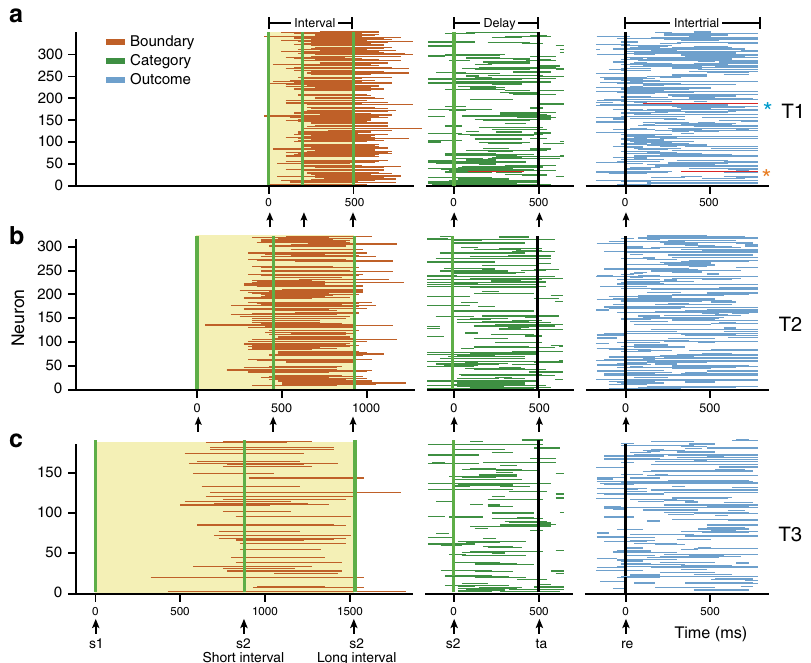
Fig. 9 Neural activity encoding boundary, category, and trial outcome emerged sequentially throughout the task. Times at which pre-SMA neurons of monkey 2 carried signi fi cant boundary, category or outcome information for T1 ( a ), T2 ( b ), and T3. c Each row corresponds to a single neuron. Orange asterisk in a left indicates the neuron in Fig. 7a. Blue asterisk indicates neuron in Fig. 8a. Arrows at the bottom of each graph indicate task events. Boundary- related activity (left panel, brown) is aligned to the interval onset (s1); the offset of the shortest (s2 short) and longest (s2 long) intervals are indicated. Category-related activity (center panel, green) is aligned to the interval offset (s2). Outcome-related activity (right panel, blue) is aligned to reward delivery